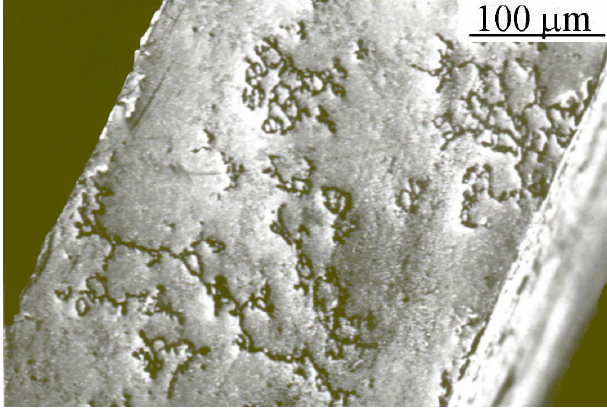
Figure 2. Intergranular cracks in the Pd-Ag